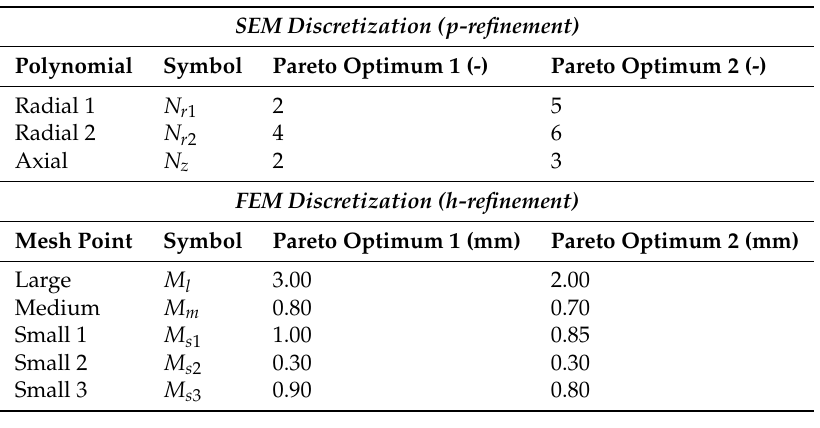
Table 4. Discretization of the polynomial degree ( p -refinement) and mesh points ( h -refinement) in the SEM and FEM model, respectively, at the two Pareto